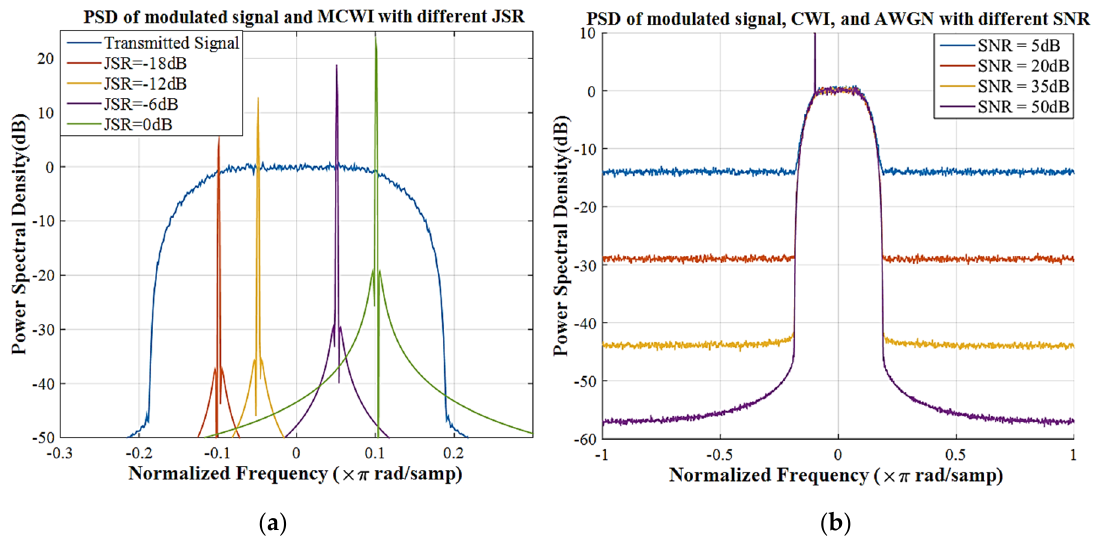
Figure 1. Clarity of Continues Wave Interference (CWI) on a modulated signal in different conditions: ( a ) different Jamming to Signal Ratio (JSR) and ( b ) different Signal to Noise Ratio (SNR).